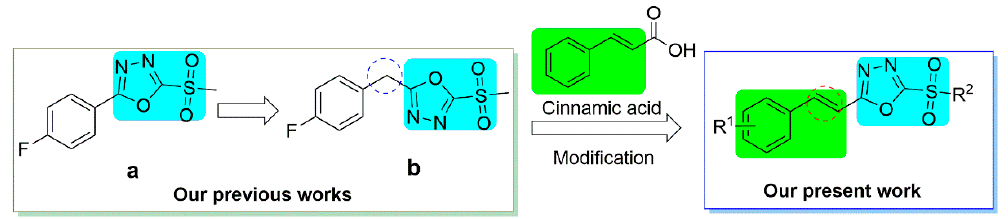
Figure 1. Design of the target compounds.